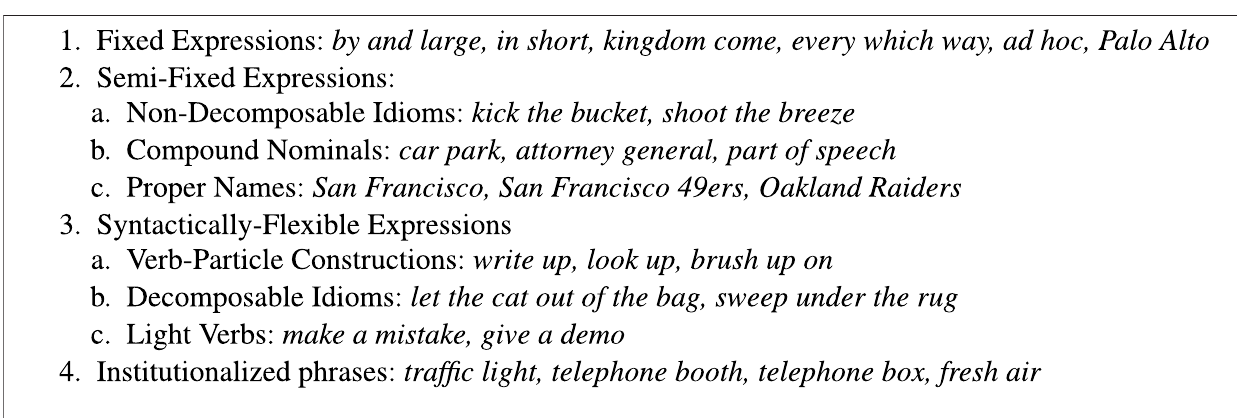
FIGURE 1 | A taxonomy of Multiword Expressions (MWEs) from Sag et al.